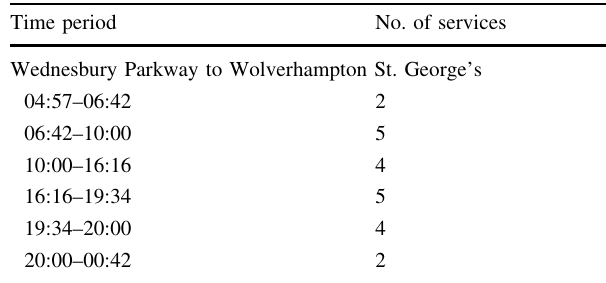
Table 2 No. of services from Birmingham Grand Central to Wolverhampton St. George’s (section 2) Time period No. of services Birmingham Grand Central to Wolverhampton St. George’s